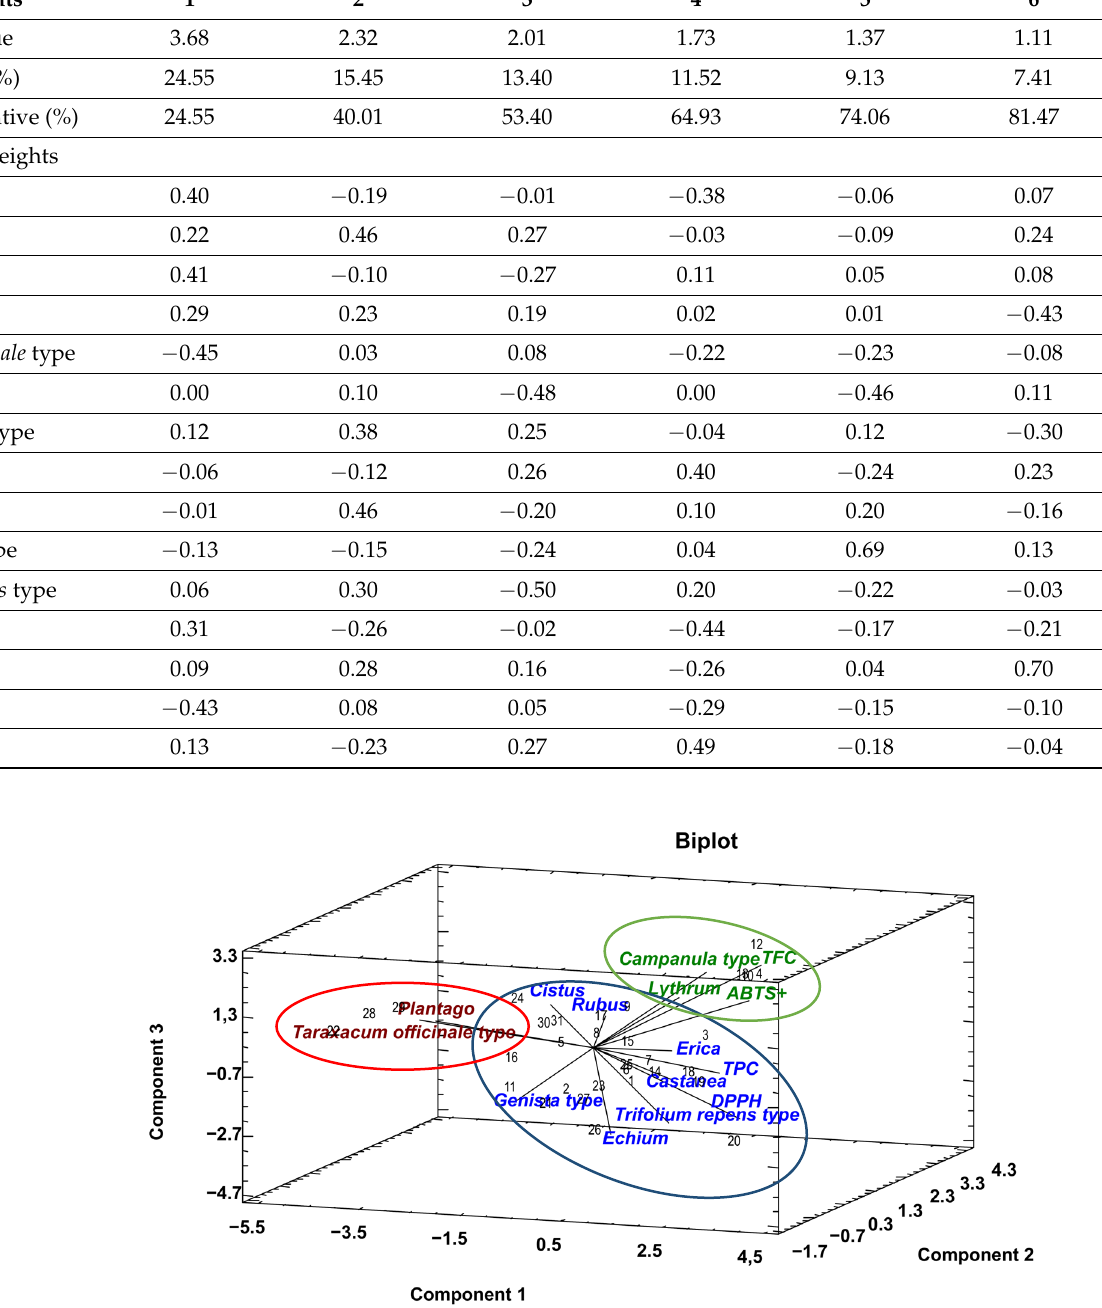
Figure 3. Plot of the first three principal components with the palynological and chemical variables obtained by PCA.